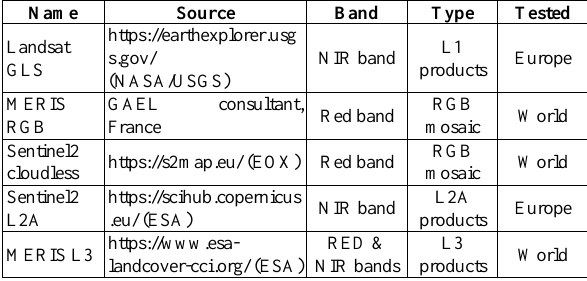
Table 2. Global datasets tested for the purpose of absolute GQA of MSG SEVIRI images.